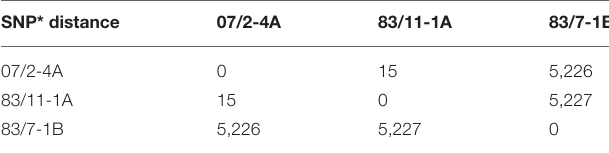
TABLE 3 | SNP matrix of S. hyicus strains